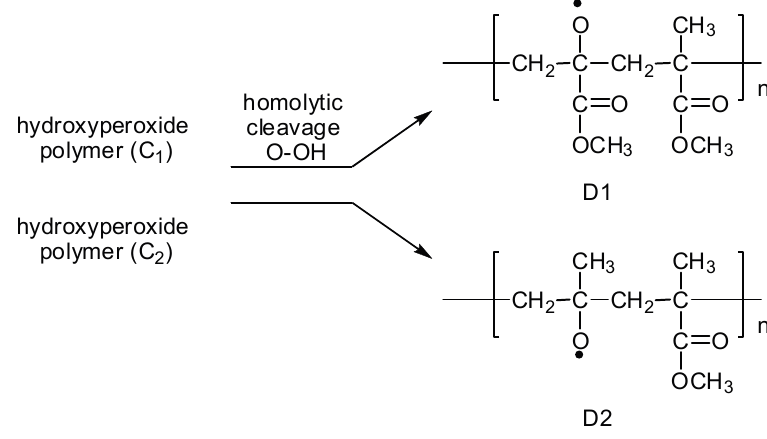
Figure 5. Formation of polymer oxy radicals D 1 and D 2